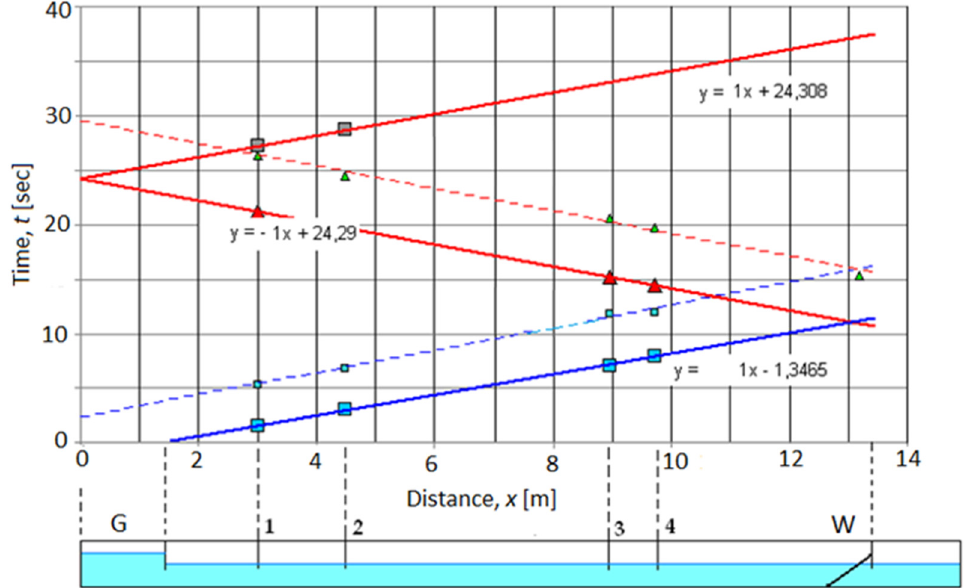
Figure 7. The diagram ( x-t ) of gravity tsunami-like waves, which propagate in the hydrodynamic channel at the following initial parameters: η 0 = 15 mm, H = 102 mm, A/H = 0.074. Makers—experiments. Lines—linear theory of shallow water. The blue line is the trajectory of the incident wave; the red lines are the reflected waves. G —wave generator; W —reflecting wall; 1–4—locations of wave level sensors.